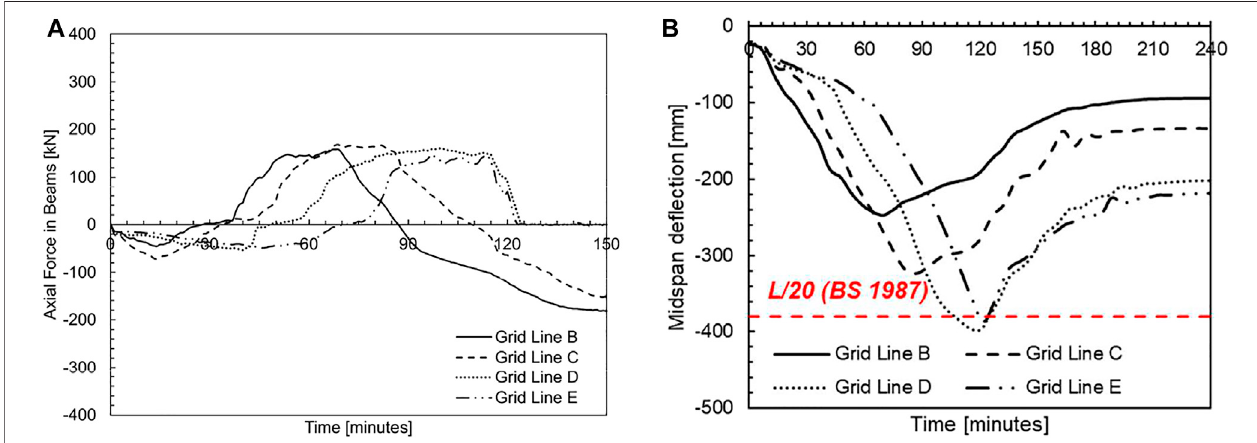
FIGURE 20 | Behavior of secondary beams spanning between MRF and gravity columns in Fire Scenario #3 (SFE Model) (A) axial force histories and (B) midspan de fl ection histories.